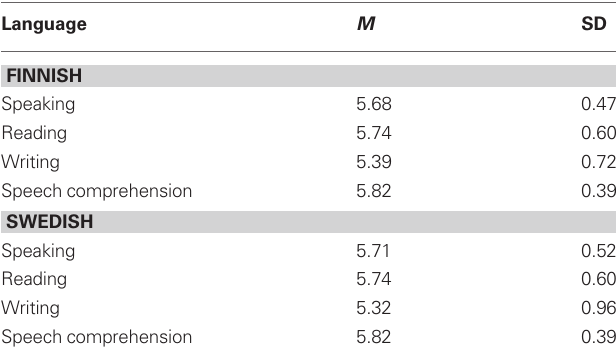
Table 2 | Summary of the participants’ estimations of their language